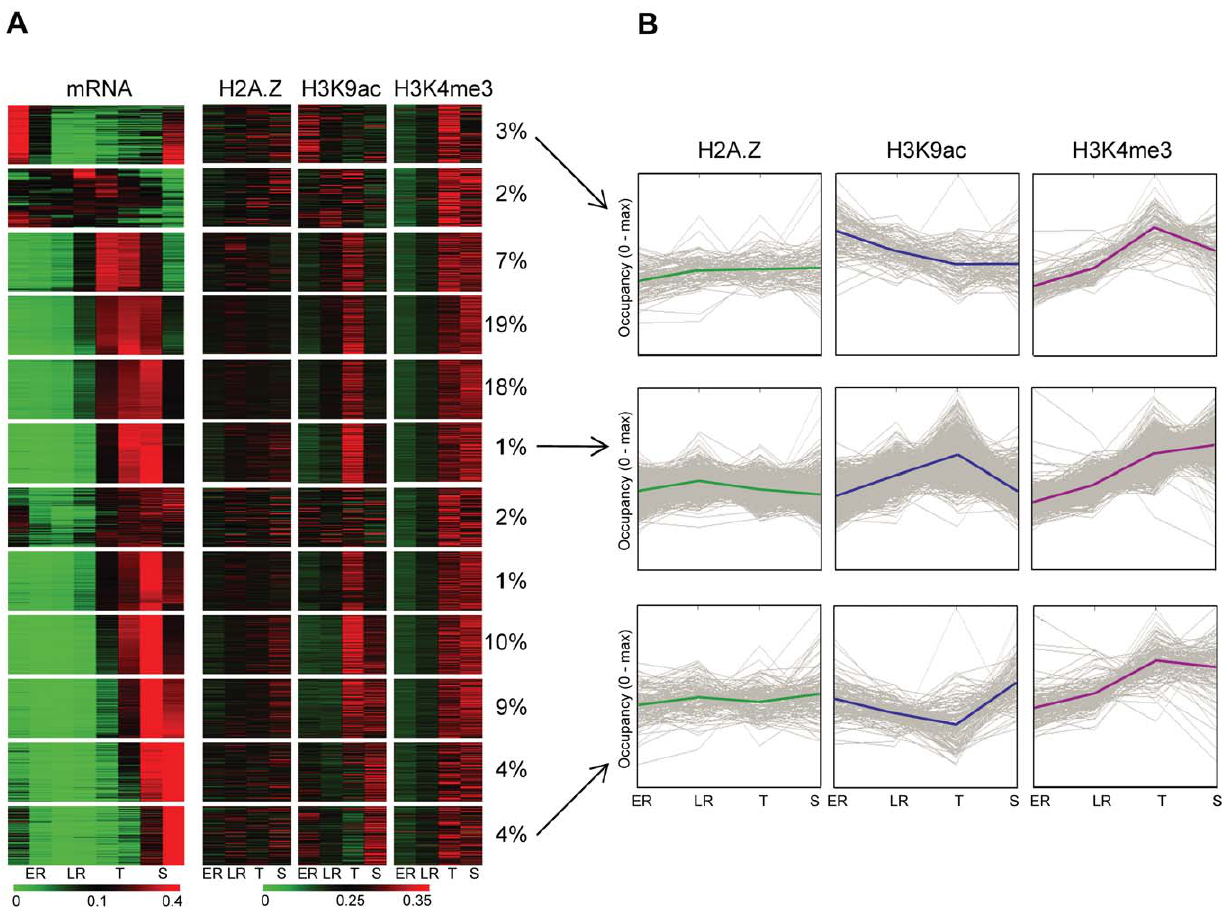
Figure 4. H3K9 acetylation dynamically associates with transcriptional activity during intraerythrocytic development. ( A ) Heatmap representation of the relative transcriptional activity of , 3800 euchromatic genes and relative H2A.Z occupancy or H3K9ac/H3K4me3 marking upstream of genes throughout intraerythrocytic development (1 equals to the sum of occupancy values at all stages). 12 groups of genes were identified based on their transcriptional profile using k-means clustering. Note that this clustering has been performed after correcting for total transcriptional activity per nucleus (Figure S4). The percent of genes belonging to each cluster are displayed next to the cluster. ( B ) H2A.Z, H3K9ac and H3K4me3 profiles were plotted through development for 3 clusters of genes (from Fig. 4A, indicated by arrows) with maximum transcriptional activity at the beginning (top), in the middle (middle) or at the end (bottom) of the intraerythrocytic cycle. Y-axis was scaled to maximal occupancy. Solid lines represent average H2A.Z, H3K9ac or H3K4me3 profiles for each cluster, grey lines represent individual